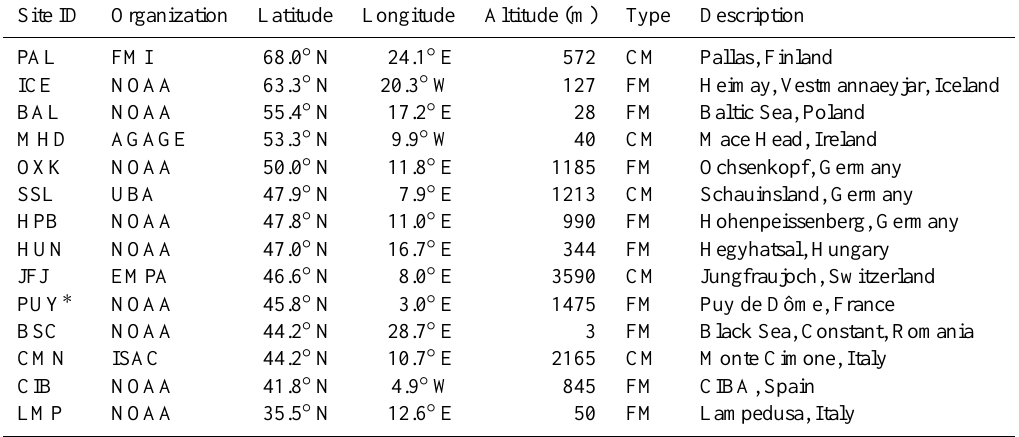
Table 3. Atmospheric observation sites for CH 4 mole fraction used in the case study. The altitude is given in metres above sea